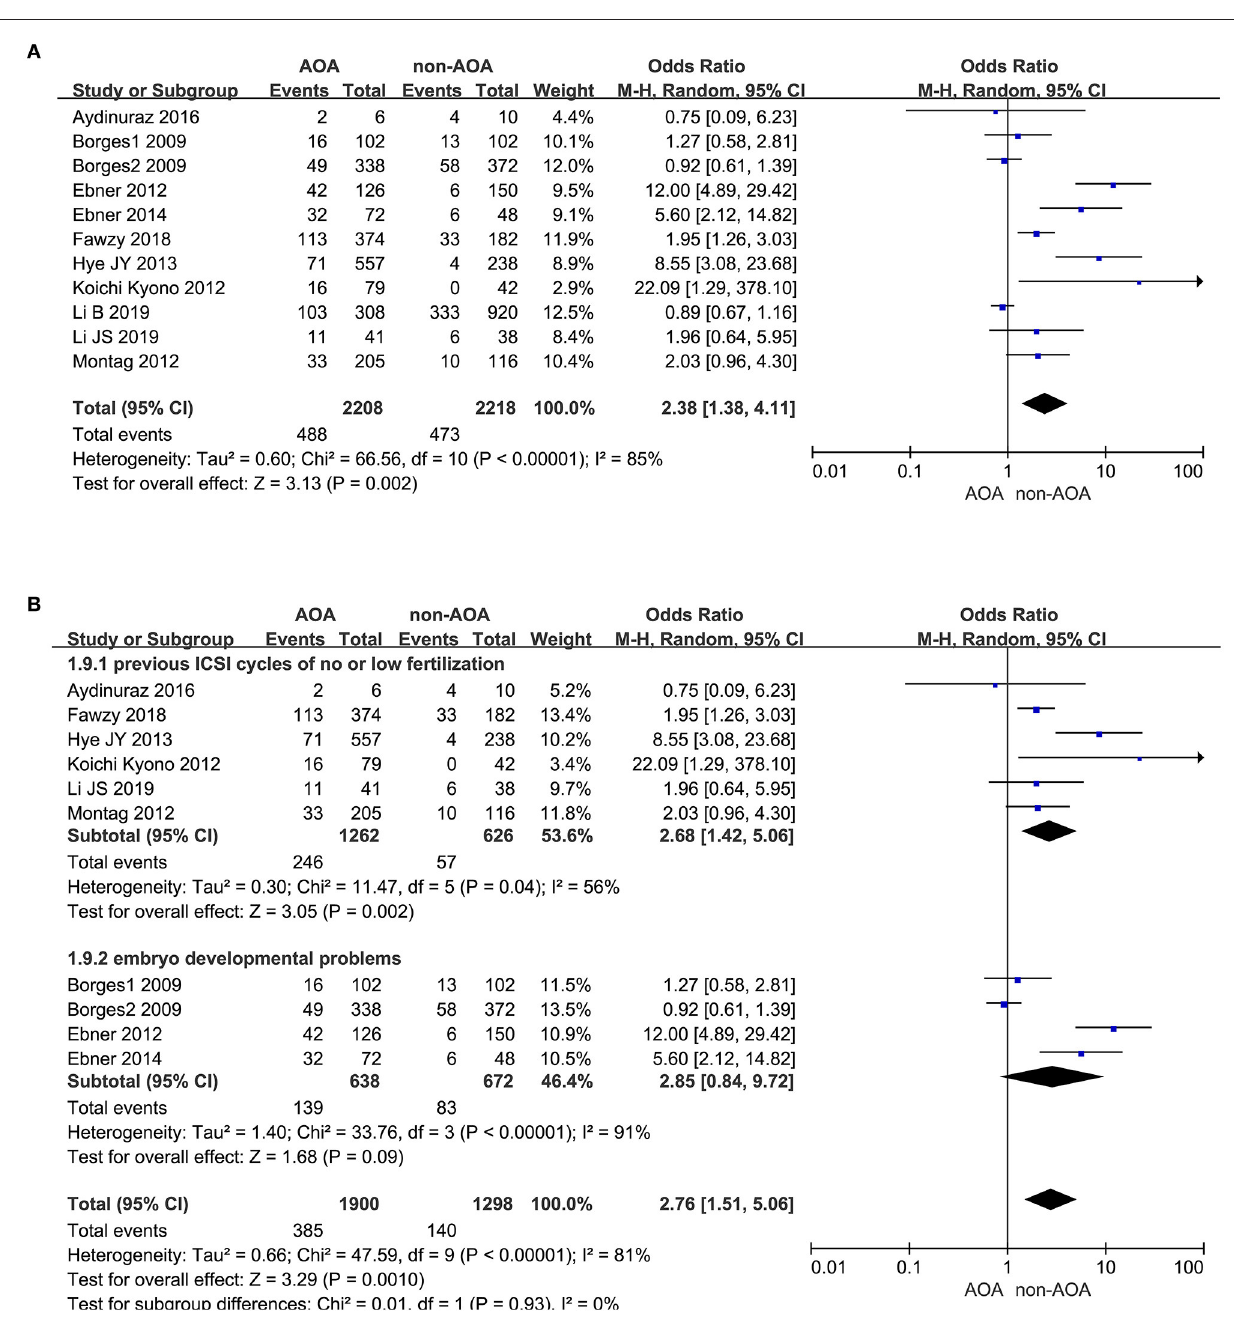
the same underlying causative effect which is a reduced/depleted intracellular calcium level. Luckily, Ebner et al. did apply the Ca 2 + -ionophore stimulus exactly at the same time for both to their ethical vote, so that the application mode was exactly